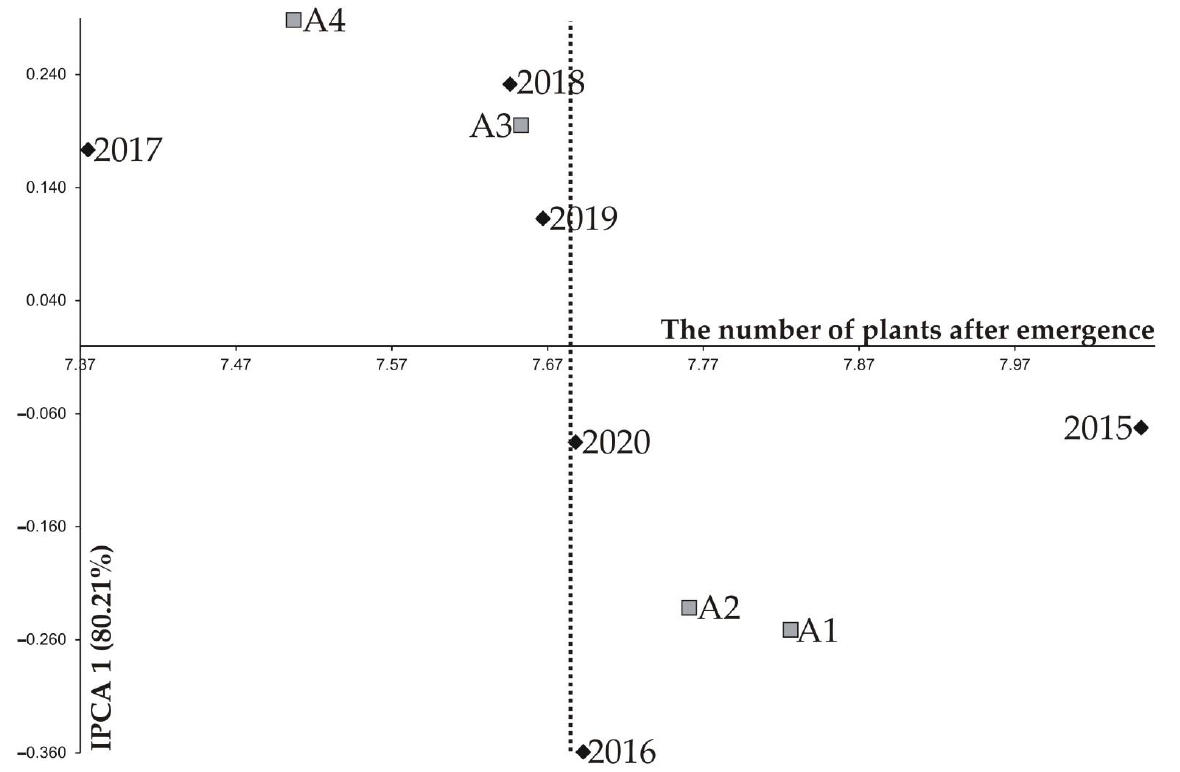
Figure 3. Biplot for the interaction principal component (IPCA 1) and average number of plants after emergence (plants m −2 ). Vertical line in the biplot center is the grand mean (A1—0 cm (broadcast), A2—5 cm (in rows), A3—10 cm (in rows), A4—15 cm (in rows)).